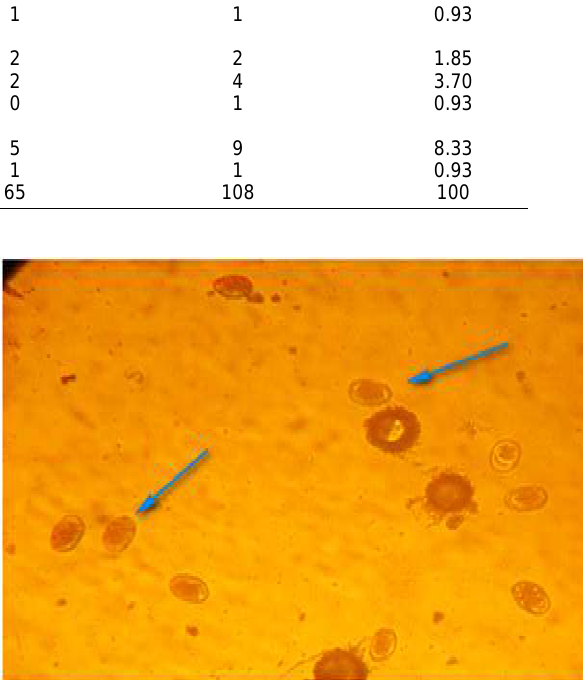
Figure-2. Photomicrograph of Strongyle eggs isolated from faecal sample of camel during the rainy season in